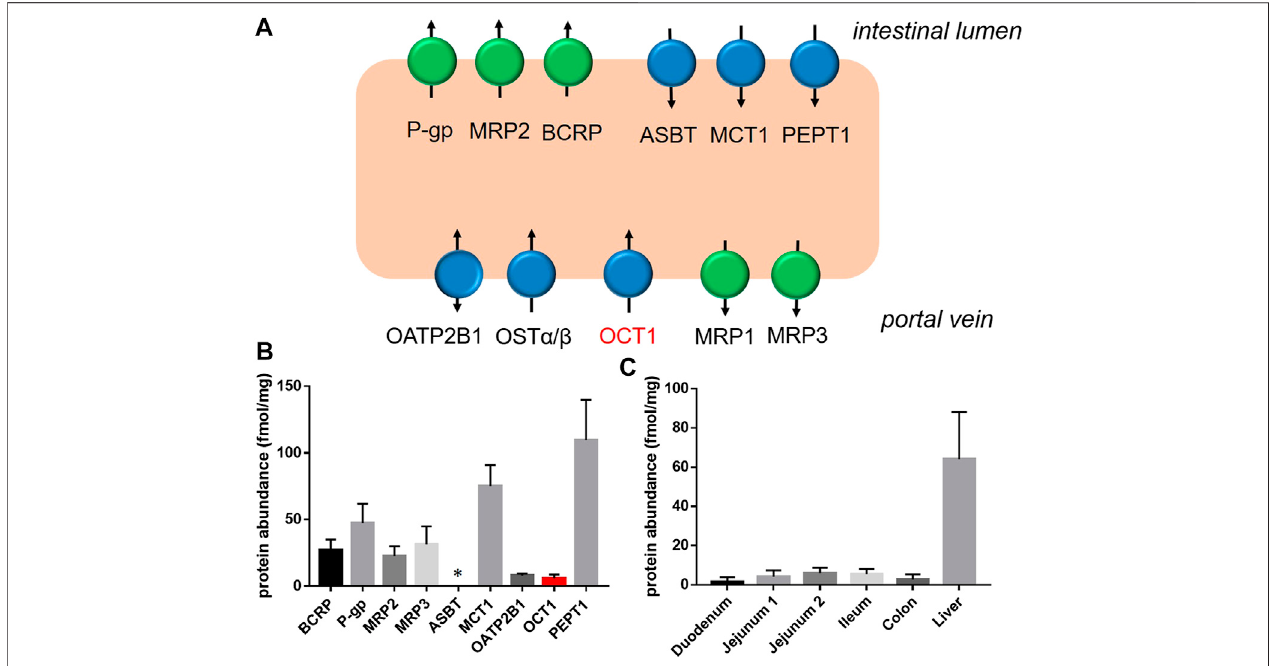
FIGURE 1 | Intestinal drug transporters: (A) , Schematic overview of clinically relevant transporters in human enterocytes (blue symbols, SLC transporters; green, ABC transporters); (B) , Protein abundance of clinically relevant transporters in the human jejunum, and (C) , of OCT1 in different intestinal segments and the liver as observed in nine organ donors using the targeted proteomics approach (Drozdzik et al.,